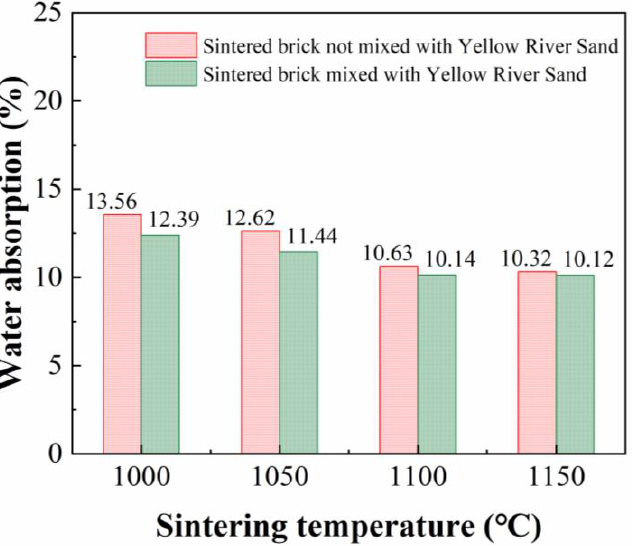
Figure 12. Effect of sintering temperature on water absorption of MGS sintered brick.